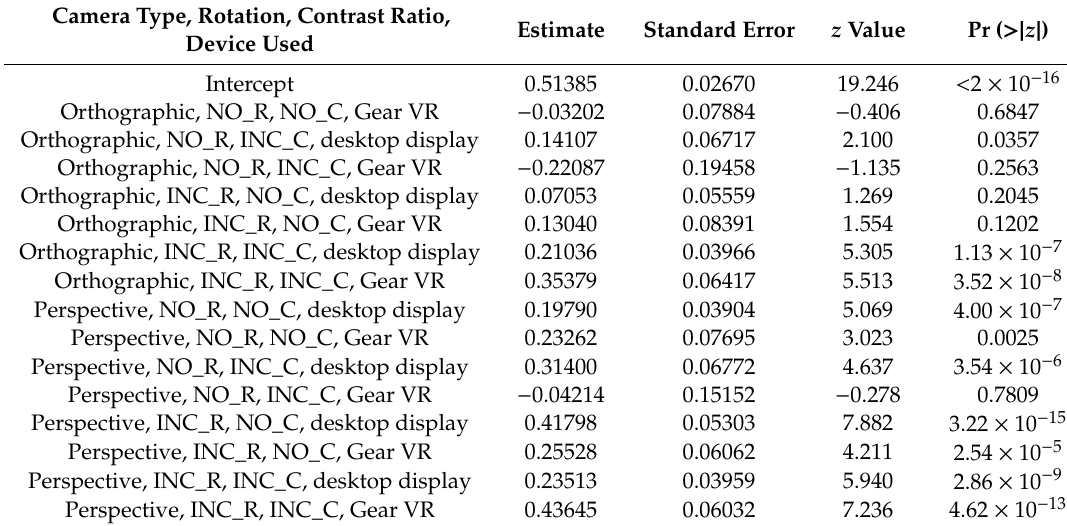
Table 37. Logistic regression analysis results investigating the e ff ects of the camera type, rotation, contrast ratio, and device